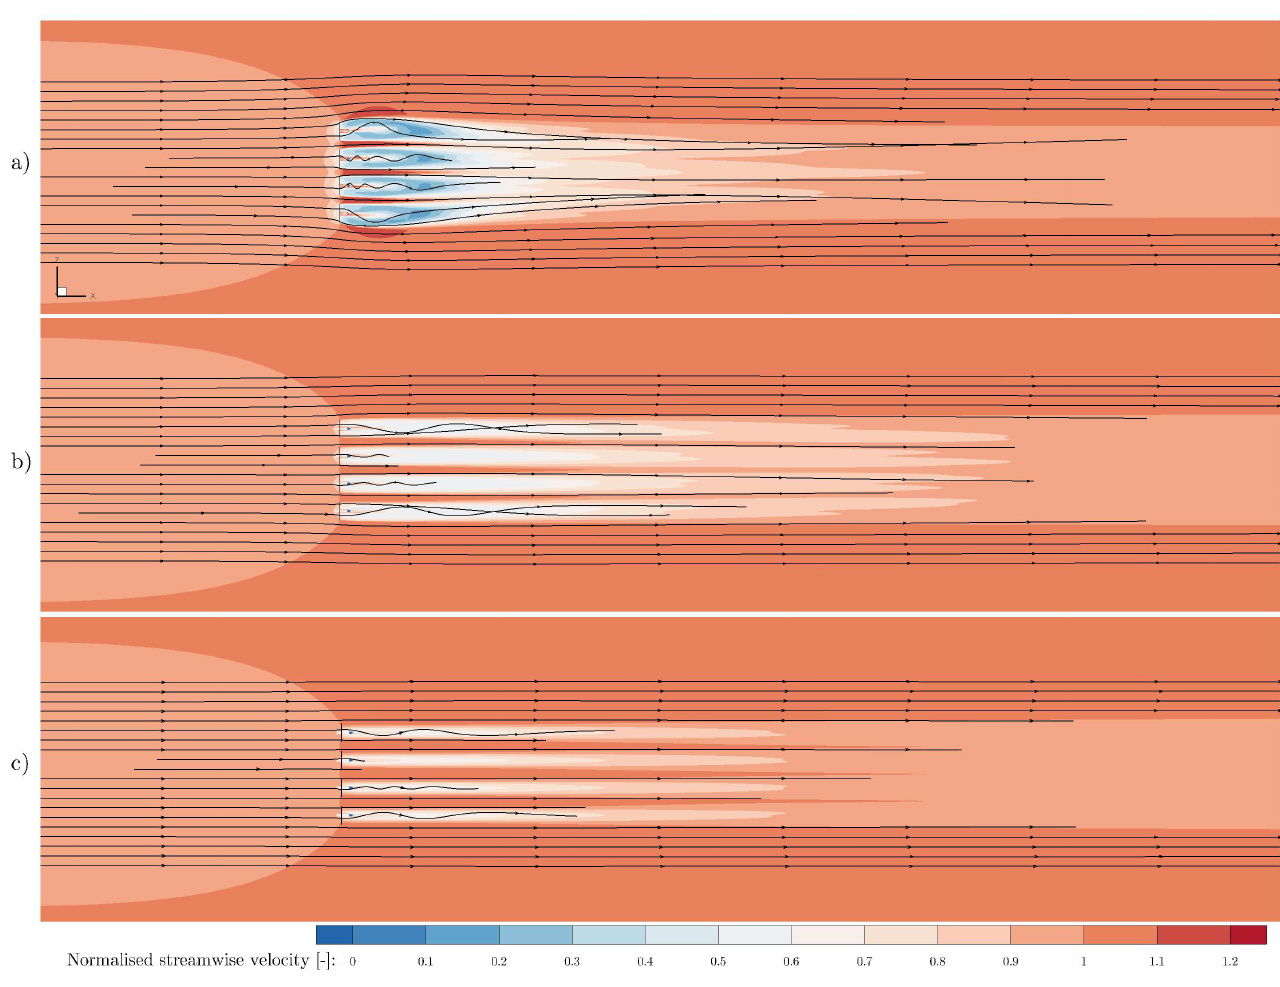
Fig. 6. Contour plot of hub-height streamwise velocity normalised by the reference flow speed past a four turbine fence with turbines of the Case 5 ( B L = 0 . 1960) design for three flow speeds: a) u ∞ = 1 . 80 ms − 1 , b) u ∞ = 2 . 00 ms − 1 , and c) u ∞ = 3 . 50 ms − 1 . Streamtraces have been added help to illustrate fence and turbine flow expansion in each